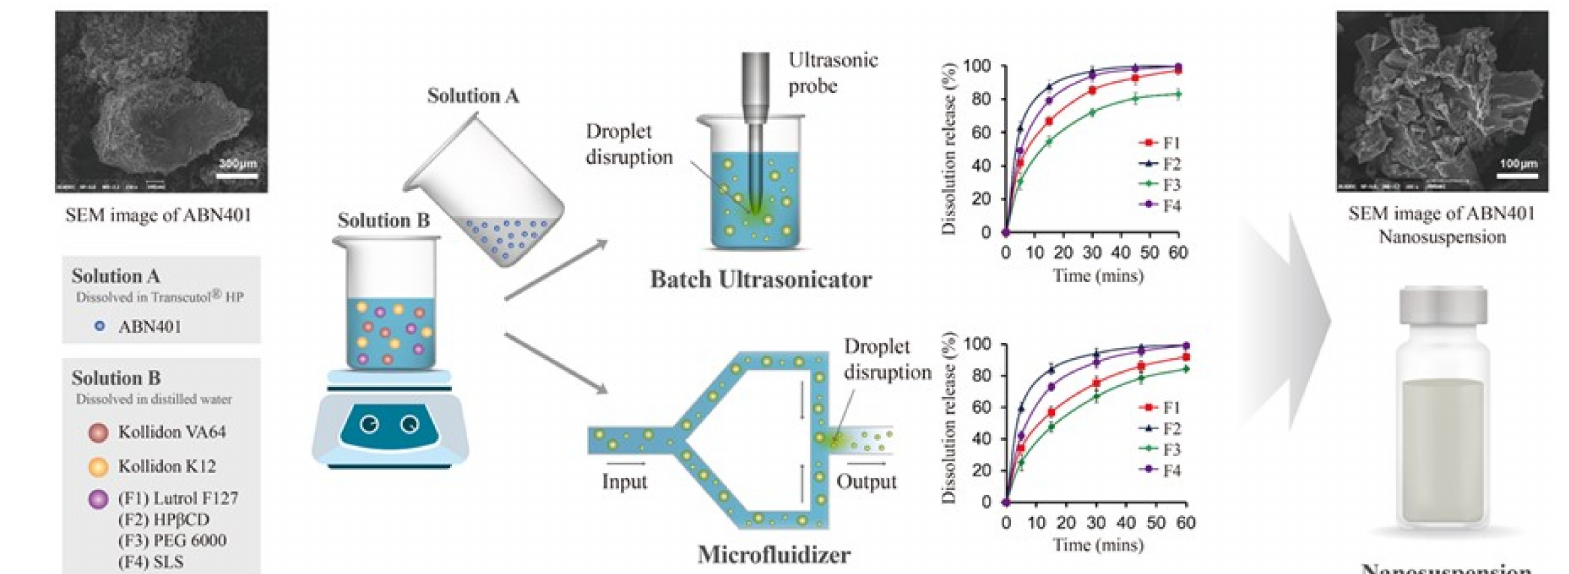
Figure 7. Schematic diagram of nanosuspension formation using liquid anti-solvent